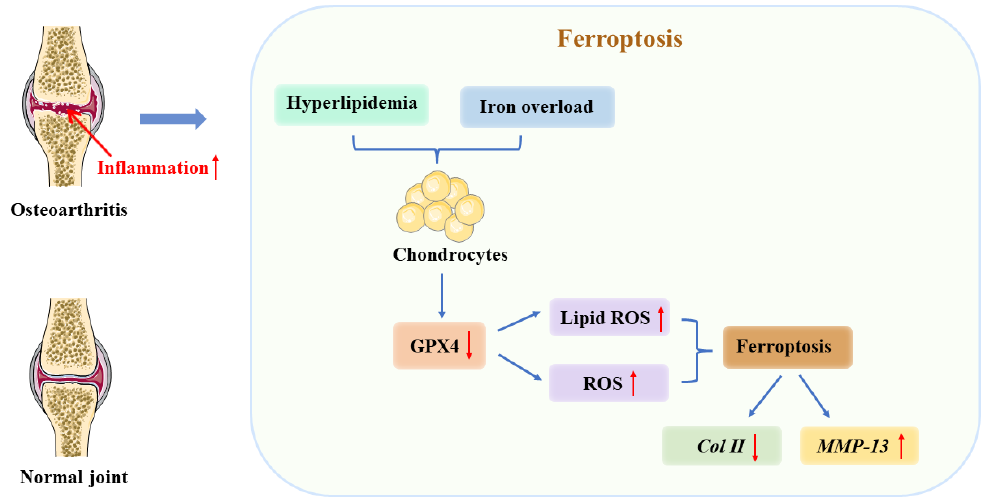
Figure 3. The relationship between ferroptosis and osteoarthritis (OA). As a result of iron